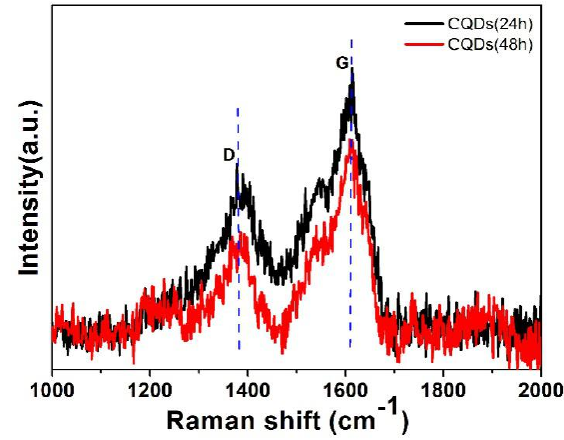
Figure 10. Raman spectra ( λ ex = 514 nm) of CQDs (24 h) and CQDs (48 h).